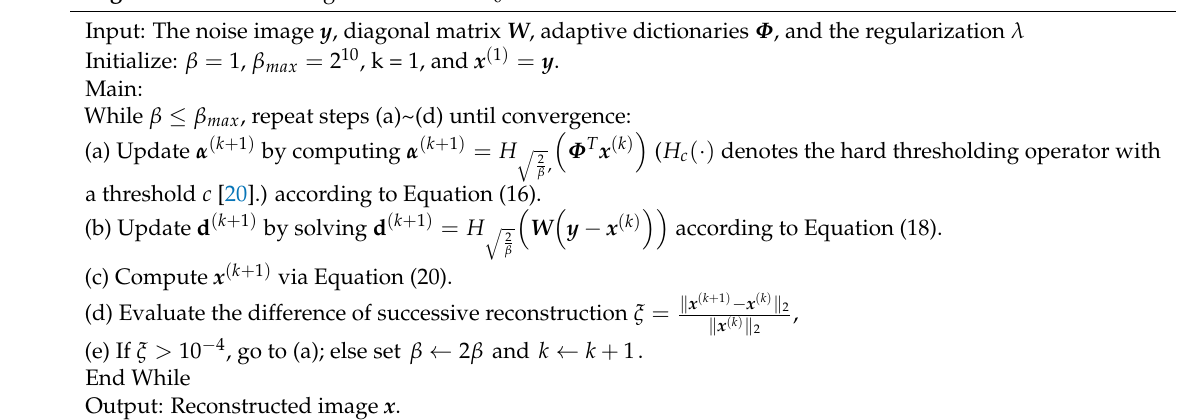
Algorithm 1. ADMC Algorithm for the L 0 Norm Minimizations.